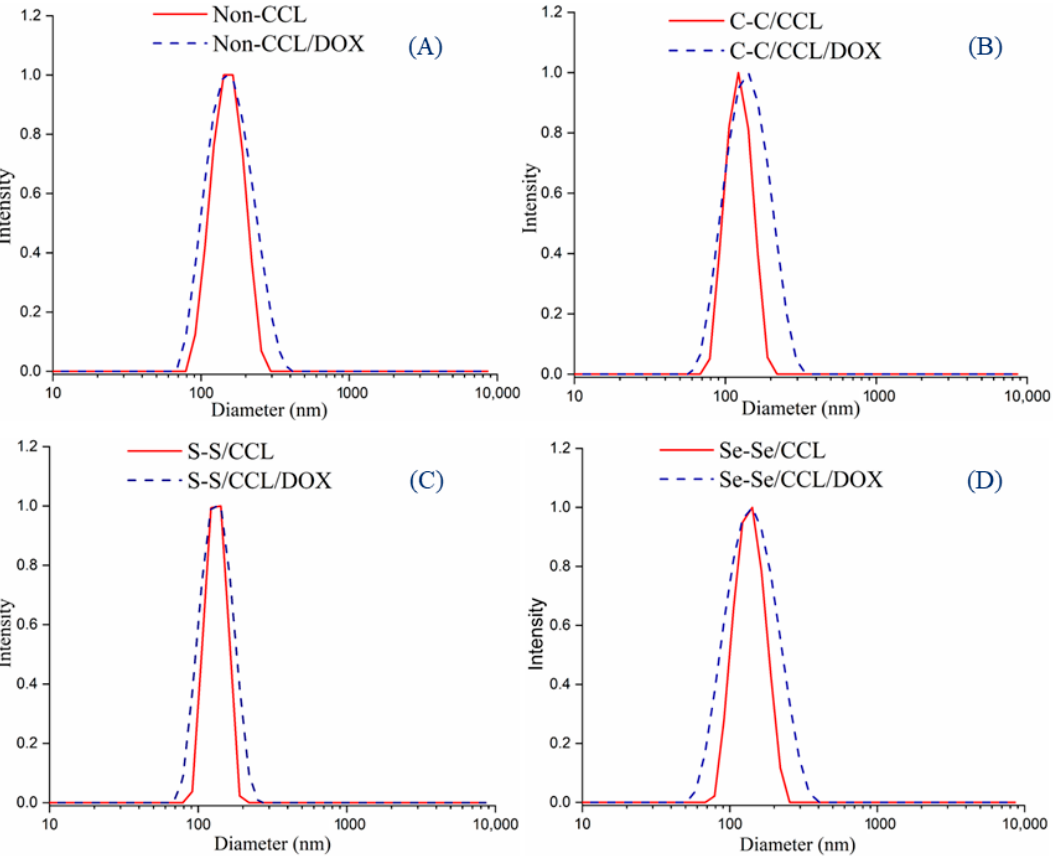
Figure 5. DLS pro fi le of non-CCL, C–C/S–S/Se–Se CCL micelles with or without DOX ( A – D ). Figure 5. DLS profile of non-CCL, C–C/S–S/Se–Se CCL micelles with or without DOX ( A – D ). Table 2. Size, PDI, LC, and LE of prepared micelles before and after DOX encapsulation.